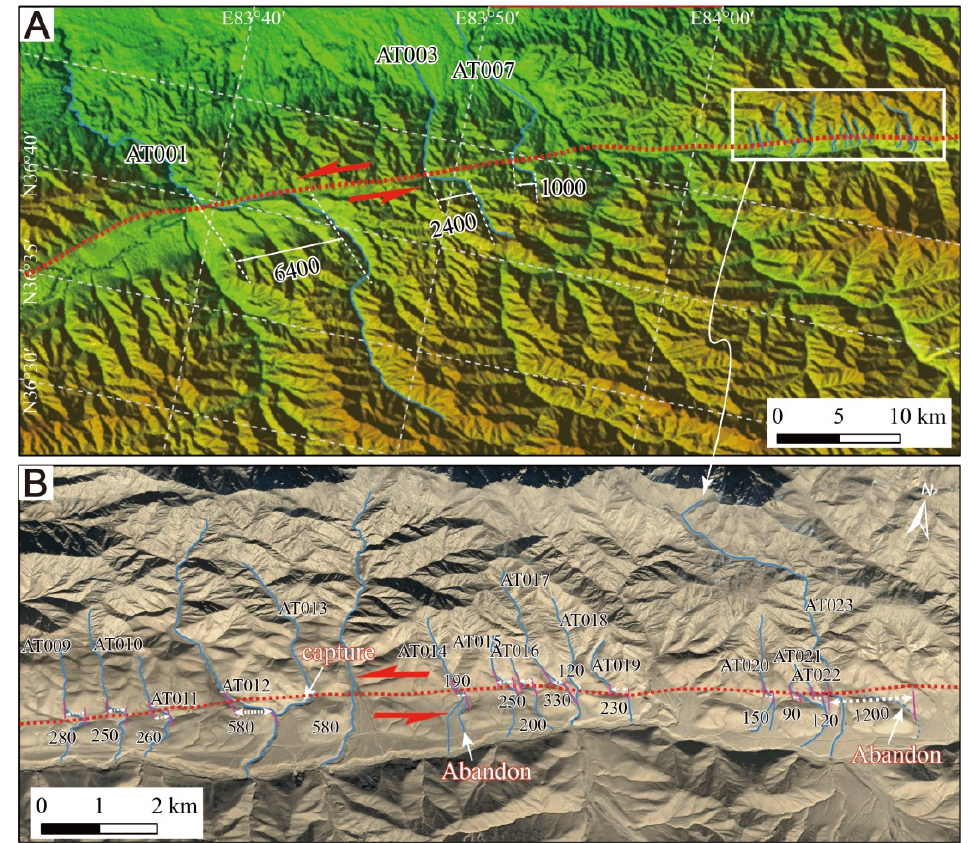
Figure 2. ( A ) SRTM 90 m resolution color-shaded relief map showing the topography features and offset large river channels (see Figure 1B for location, Table S1 for measurement uncertainty). ( B ) High-resolution Google Earth images showing the offset of small rivers (AT009–AT023) with a relatively short upstream length. Red dotted line indicates the active fault trace. All the offsets are in meters.